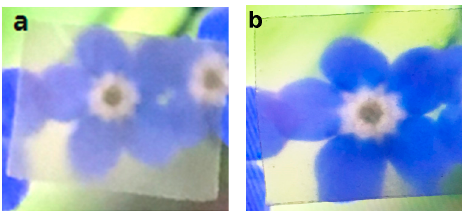
Figure 11. ( a ) Image of the CNF-II film; ( b ) image of the CNF-II/acrylic resin composite film.